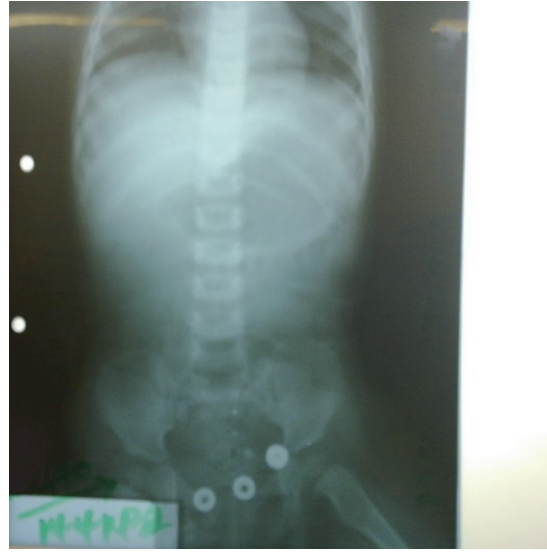
Figure 1 : Normal plane X-Ray of the abdomen.